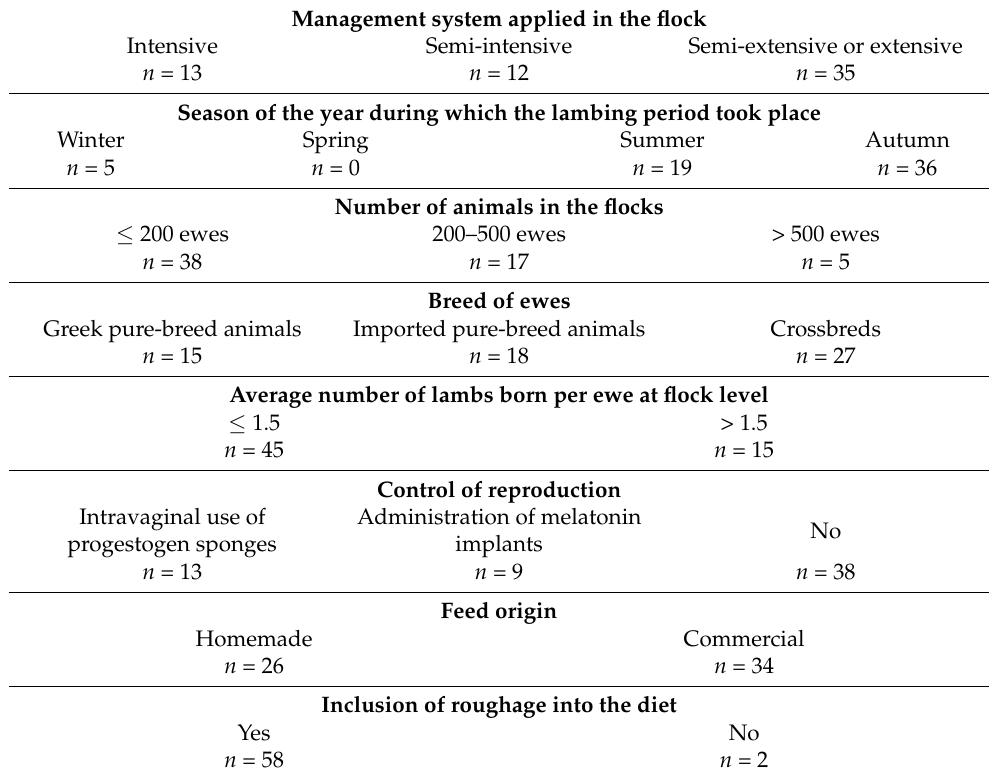
Table A2. Characteristics of the variables ( n = 15; flock-level factors) evaluated for potential associa- tion with peri-parturient deaths in 60 sheep flocks in